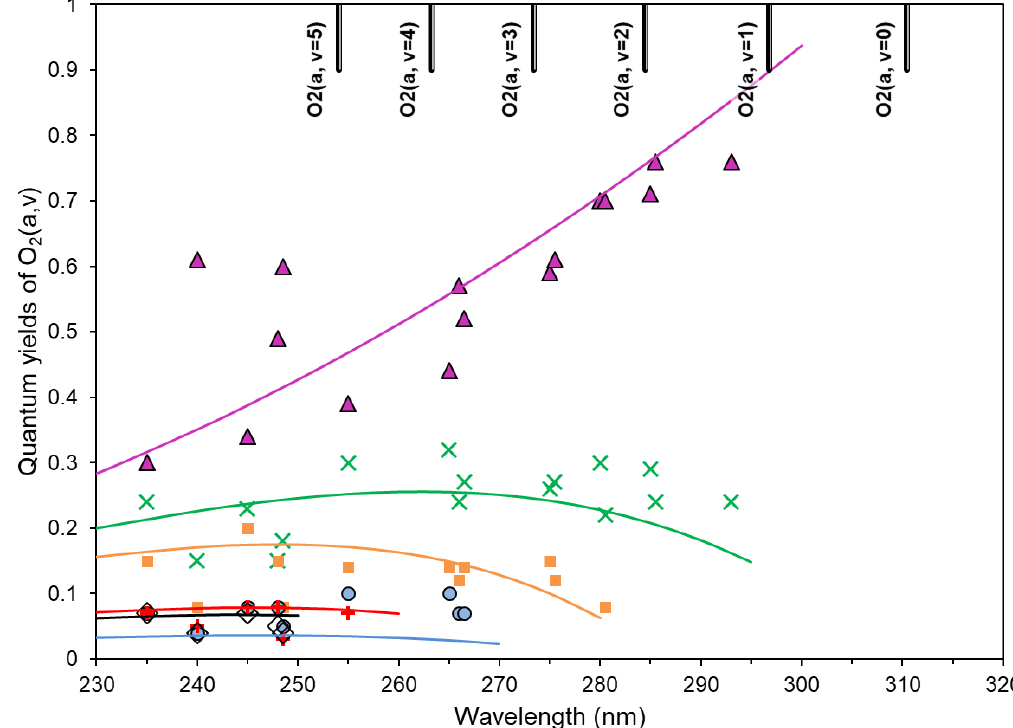
Figure 3. Quantum yields of O 2 (a 1 Δ g , v = 0–5), which are produced in result of the O 3 photolysis in Hartley band. Experimental data: violet triangles (v = 0), green crosses (v = 1), orange squares (v = 2), blue circles (v = 3), red pluses (v = 4) and black diamond (v = 5). Calculations by Equations (3) and (4) for different v are solid lines with corresponding colors.